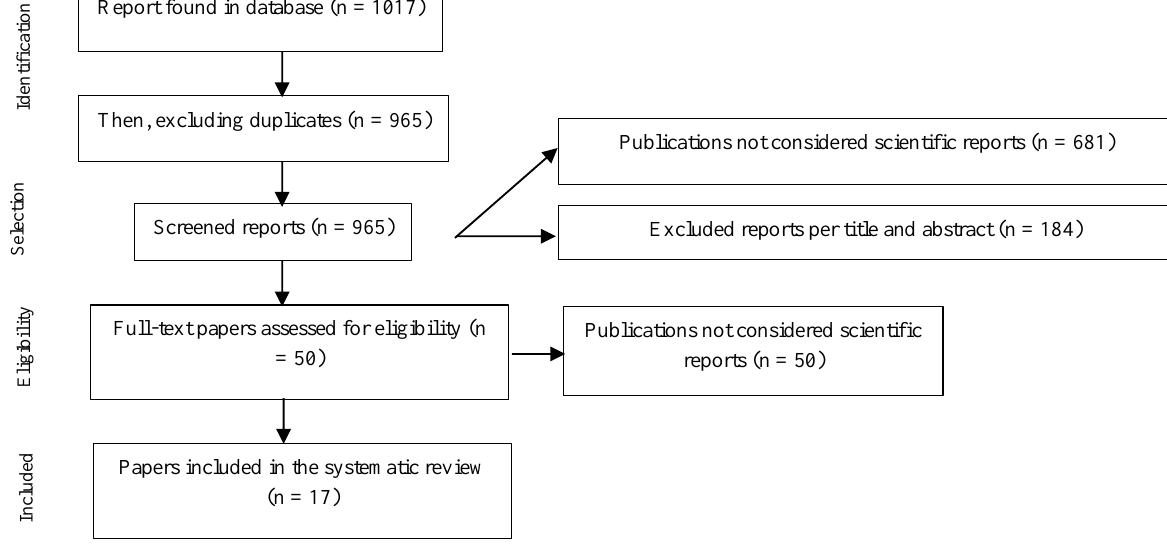
Figure 1 – Article selection process. Adaptation from Físico et al., 2020(Físico et al.,